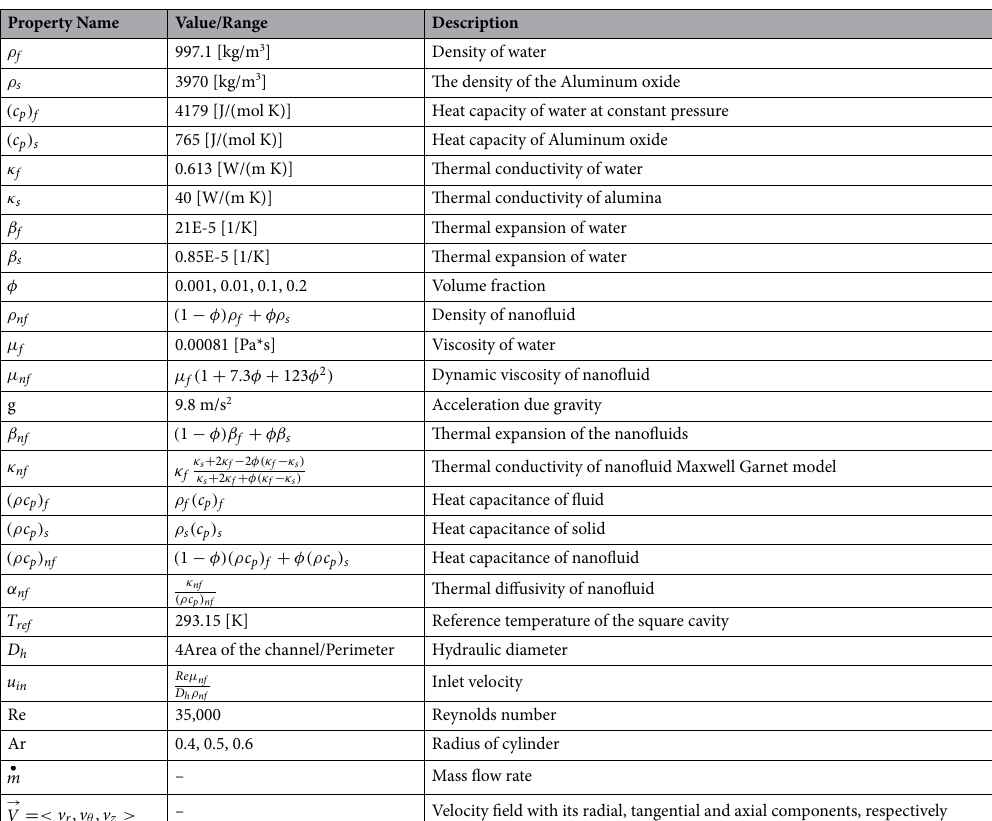
Table 1. Thermo-physical properties and other parameters for computer simulations 38,39